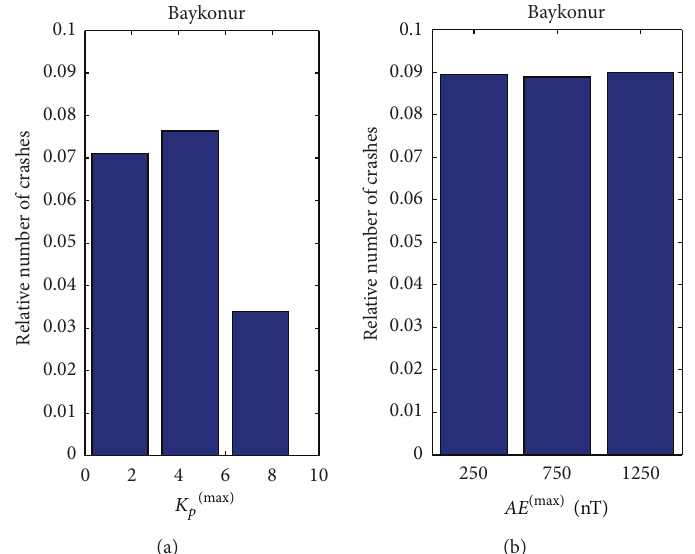
Figure 10: Relative number of crashes for different levels of geomagnetic indices 𝐾 𝑝 (a) and 𝐴𝐸 (b) at Baykonur.